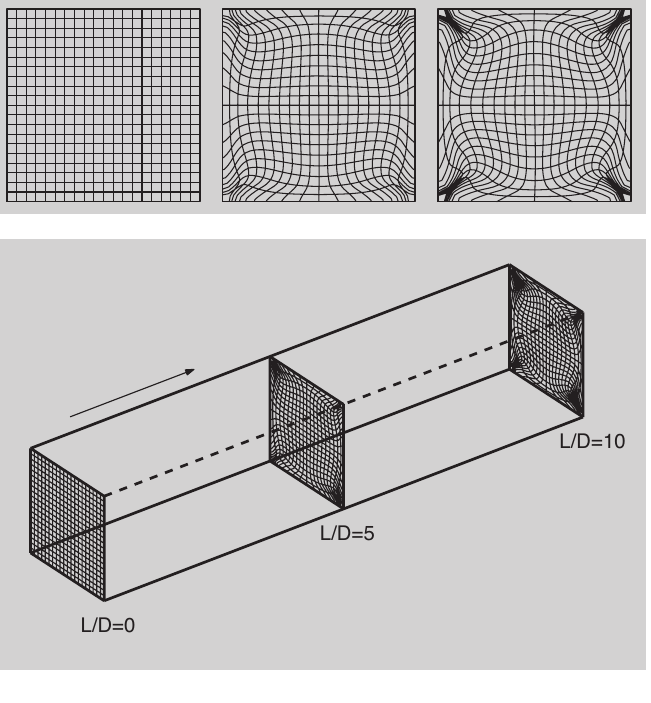
Table 1: Material parameters for the Giesekus model with five relaxation times for polystyrene. Figure 3 (left above): The figure on the left shows a coarse initial mapping grid consisting of 20 ¥ 20 cells. The figures in the middle and the right show the deformation of the grid in (a) after 5 L/D and 10 L/D respectively. The actual mapping grid con- tains 400 ¥ 400 cells. Figure 4 (left below): Schematic figure showing the initial grid and the deformed grids after L/D = 5 and L/D = 10 in the channel. Figure 5 (right above): Interface deformation evolution of six different initial (column wise) struc- tures in a square channel. Each subsequent figure in a row shows the progres- sion after a multiple of 5 L/D. The last column contains the extruded struc- ture after 50 L/D. The flow rate was 0.72 cc/s. Figure 6 (right below): Interface deformation evo- lution of six different initial (column wise) structures in a square channel. Each subse- quent figure in a row shows the progression after a mul- tiple of 5 L/D. The last col- umn contains the extruded structure after 50 L/D. The flow rate was 2.48